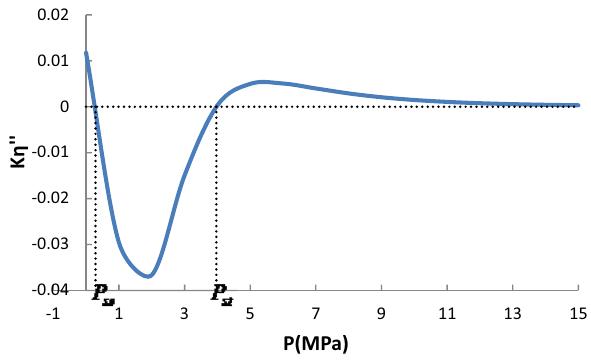
Fig. 4 The curve diagram of second derivative of curvature of des- orption curve